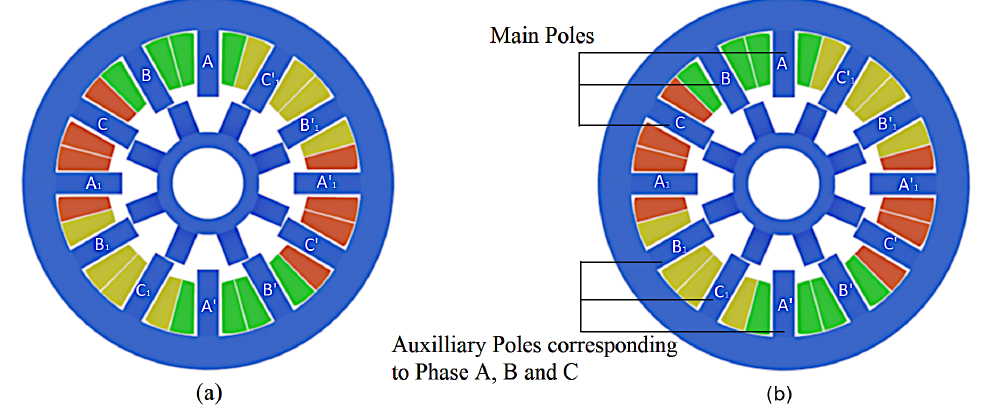
Figure 1. Machine topologies of two SRMs with the same rating as shown as ( a ) 12/8-pole conven- tional SRM and ( b ) 12/8-pole HESRM without